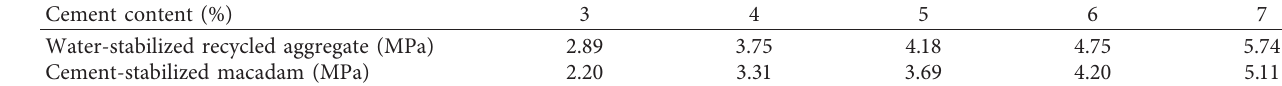
Table 6: Unconfined compression test results for seven days.